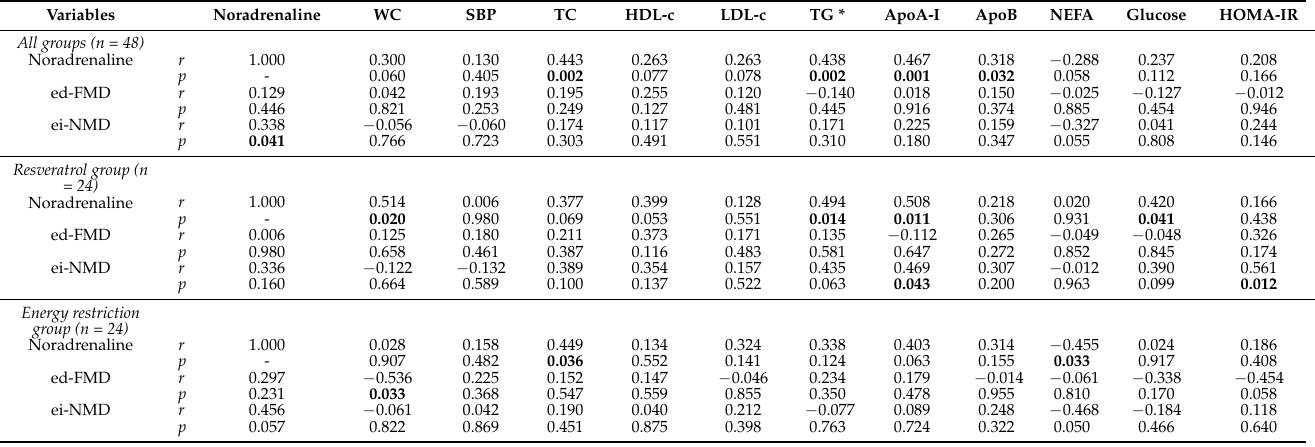
Table 2. Correlations between changes ( ∆ ) of plasma noradrenaline, vascular reactivity, and cardiometabolic parameters. Variables All groups (n = 48) Noradrenaline